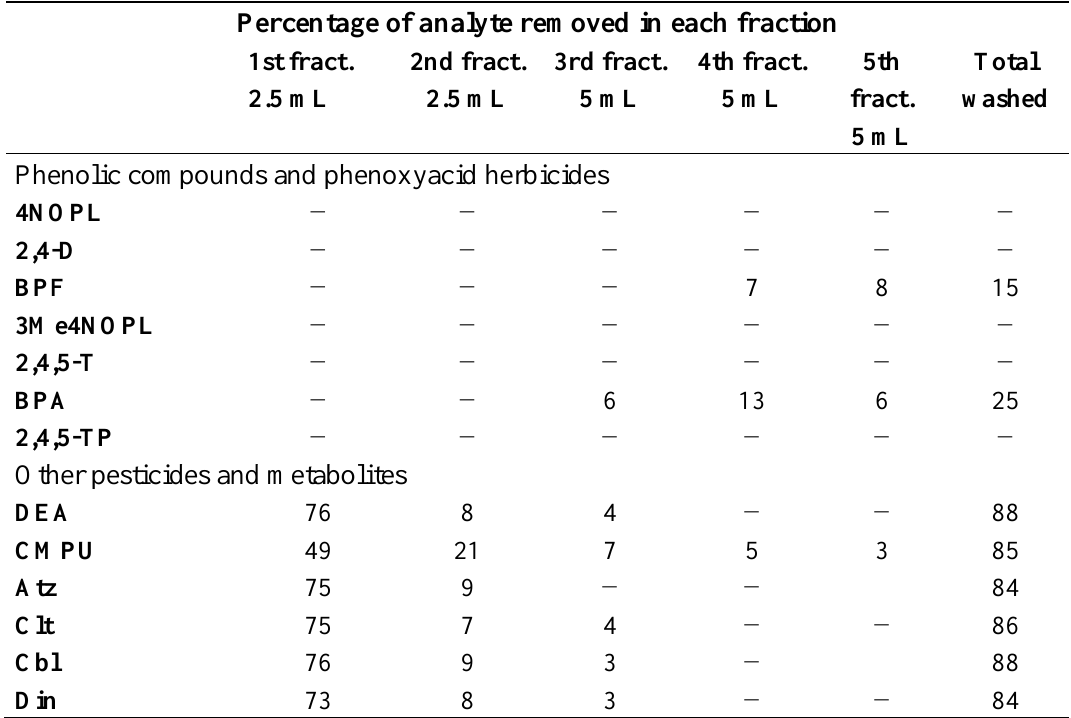
Table 2. Influence of the volume of dichloromethane used in the washing step. Sample: 5 mL of UHQ water spiked with 100  g L −1 of each